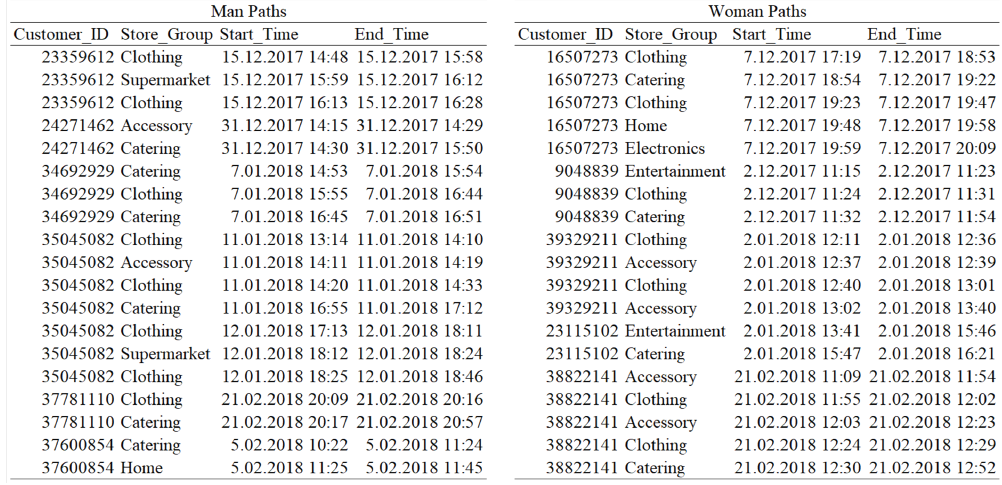
Figure 4. Sample validation data for discovered customer